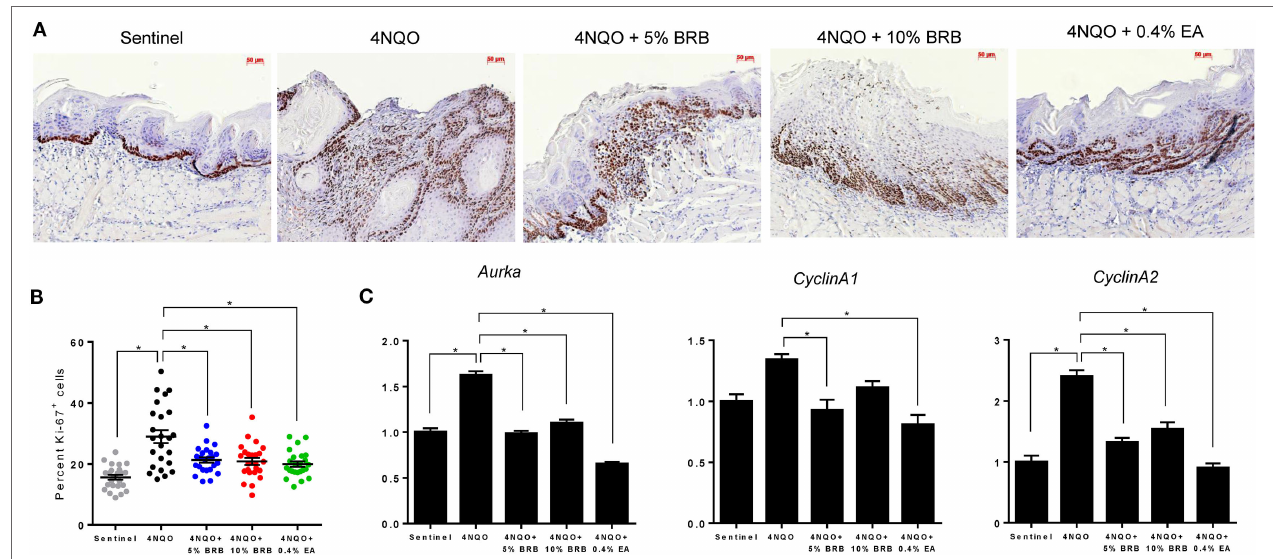
FigUre 5 | (a) Representative microscopic images ( × 200) of tongue tissues from sentinel rats and 4-nitroquinoline 1-oxide (4NQO) exposed rats fed control diet, 5% black raspberry (BRB), 10% BRB, or 0.4% ellagic acid (EA). Paraffin sections were stained with anti-Ki-67 antibody and counterstained with hematoxylin. (B) Quantitation of Ki-67 positive cells in tongue epithelial tissue from sentinel rats as well as 4NQO exposed rats fed with control diet, 5% BRB, 10% BRB, or 0.4% EA. Graphic representation of percent Ki-67 positive nuclei relative to total nucleated cells in six random fields of tongue epithelium from selected rats from each experimental group. Data are expressed as percent cells ± SE. * p -value < 0.05 for each group comparison using independent Student’s t -test. (c) Gene expression profiles of the cell cycle associated biomarkers Aurka, Ccna1 , and Ccna2 during 4NQO-induced oral carcinogenesis as determined by reverse transcription quantitative PCR. Data are presented as mean fold induction over sentinels ± SE. * p -value < 0.05 for each group ( N ≥ 20) comparison using analysis of variance